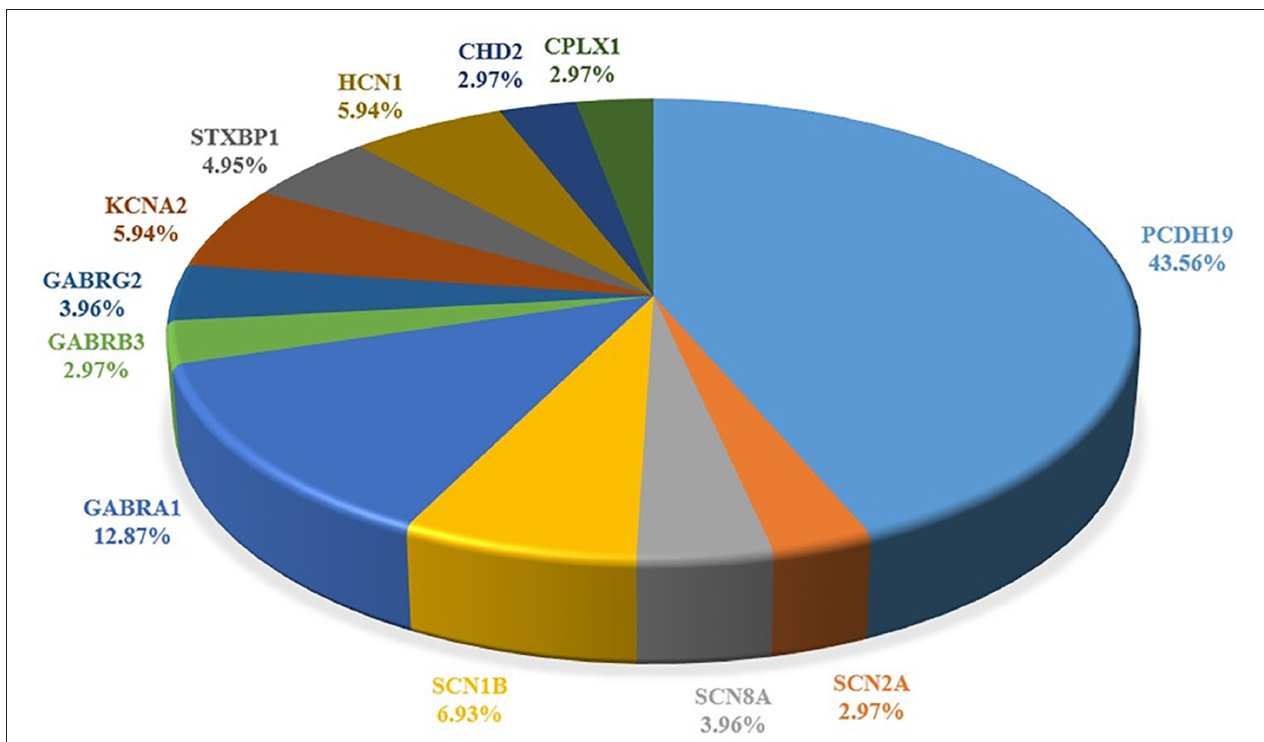
FIGURE 2 | Summary of the pathogenic genes of Dravet syndrome. Comparison of proportion of each gene in literature